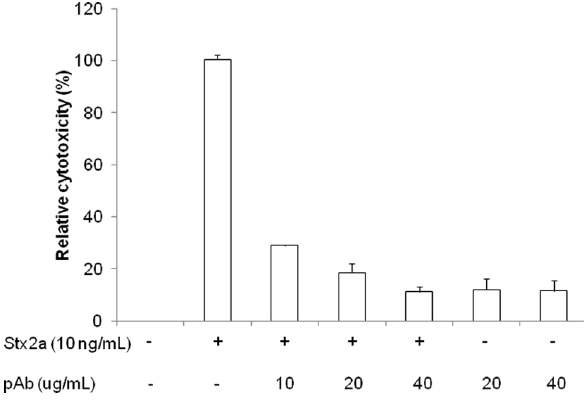
Figure 3. Neutralization of Stx2a cytotoxicity with the pAb. Vero cells were incubated in DMEM medium containing Stx2a (10 ng/ mL) with or without the presence of the pAb. The cytotoxicity to cells was calculated as [(cps from negative control – cps from samples treated)/cps from negative control] 6 100. The luminescent counts from cells grown in DMEM medium were used as a negative control. The relative cytotoxicity was calculated by normalizing each value to the cytotoxicity of Stx2a without adding pAb as 100%. The results represent the mean 6 SD of three replicates from one representative experiment. Three individual experiments were performed.